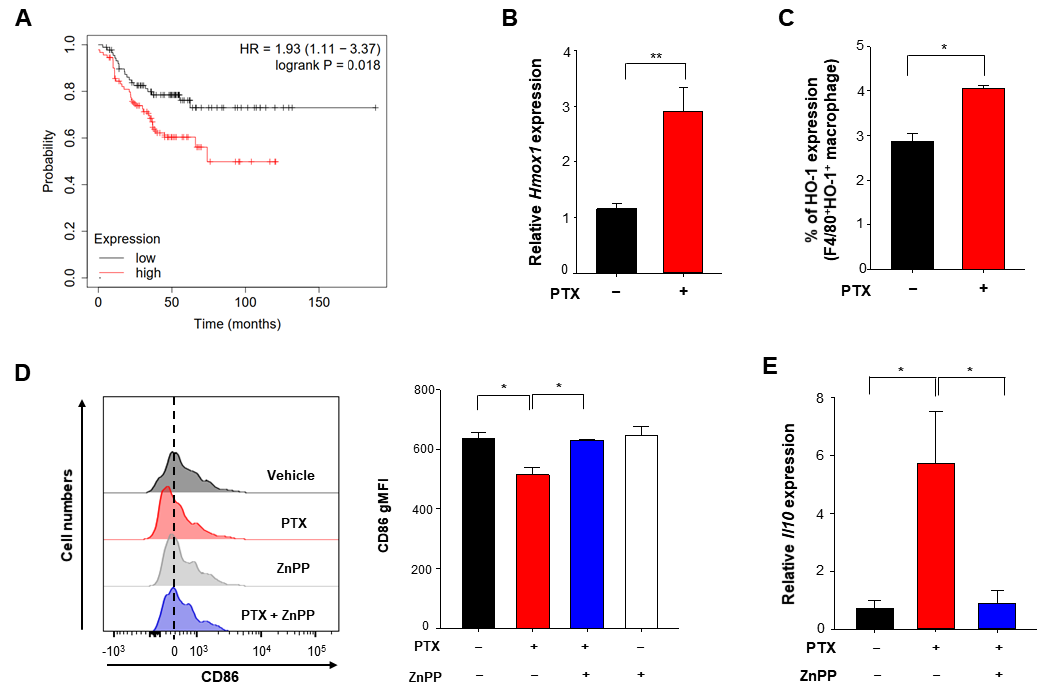
Figure 4. Induction of HO-1 by chemotherapy and its effects on macrophage polarization. ( A ) Kaplan–Meier analysis (http://kmplot.com/analysis (accessed on 29 January 2021)) of RFS (relapse-free survival) based on low or high HMOX1 mRNA (HMOX1 probe set 203665_at) expression in breast cancer patients who had chemotherapy. For animal experiments ( B – E ), 4T1 murine cancer cells were implanted into the mammary glands of female mice. Mice implanted with 4T1 cancer cells received vehicle or PTX (5 mg/kg, i.p. ) for 5 days with or without daily intraperitoneal injection of ZnPP (40 mg/kg). Mice were sacrificed on day 15 after PTX injection, and breast tumor tissues were analyzed. ( B ) Relative mRNA levels of Hmox1 in CD45 + CD11b + tumor-associated myeloid cells isolated from 4T1 tumors were assessed by qPCR. ( C ) The HO-1 expression levels in TAMs from 4T1 tumor-bearing mice injected with or without PTX were analyzed by flow cytometry. ( D ) CD45 + CD11b + Ly6G − Ly6C − F4/80 + TAM subsets of 4T1 tumors were subjected to flow cytometry to measure CD86 expression. ( E ) The mRNA levels of Il10 were measured in TAMs. *, ** Significantly different between groups compared (* p < 0.05; ** p < 0.01).